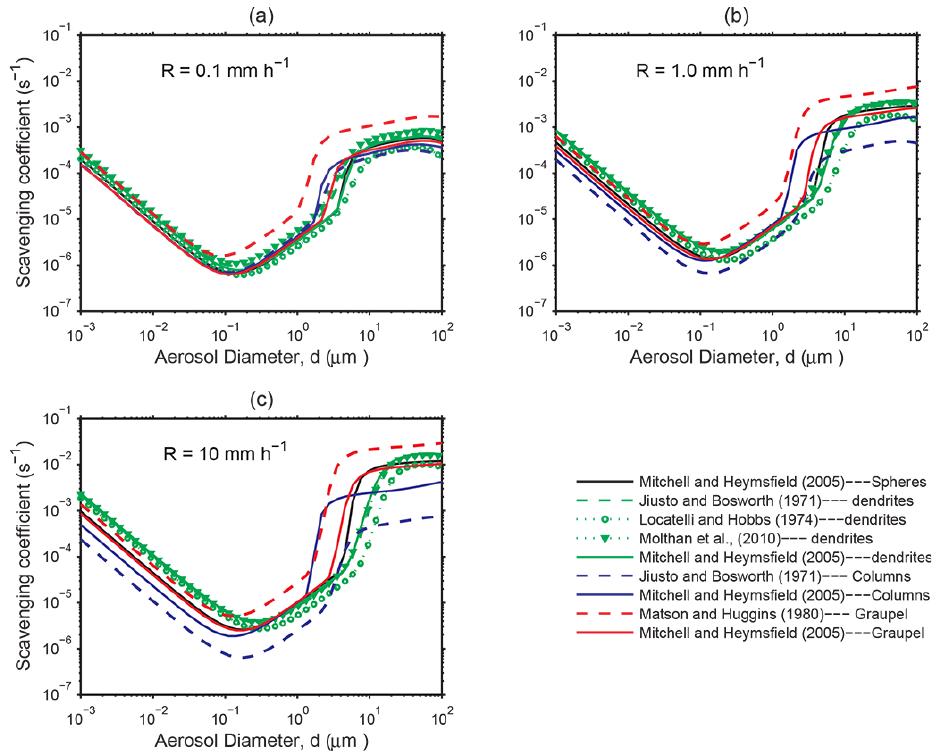
Fig. 6. Size-resolved snow scavenging coefficients 3 snow derived from using different terminal velocity parameterizations for snowfall intensities (as liquid water equivalent) of (a) 0.1, (b) 1.0, and (c) 10mmh − 1 . Note that among the four green lines, the circle one is at the bottom and the other three are close to each